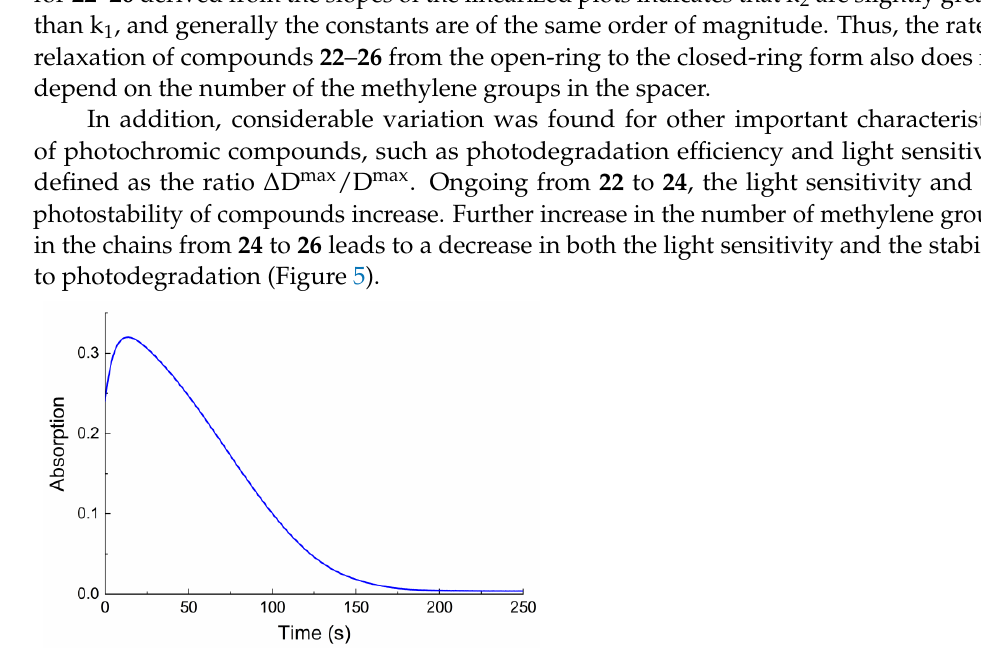
Figure 4. Normalized kinetic curves ( A ) of the transition process of the merocyanine form of 22 to the spiropyran form measured at 605 nm without (1) (dark bleaching) and upon irradiation (2) through a SZS − 9 light filter (photobleaching). Linear anamorphoses ( B ) of kinetic curves 1 and 2 in the Ln(I) – time(s) coordinates.